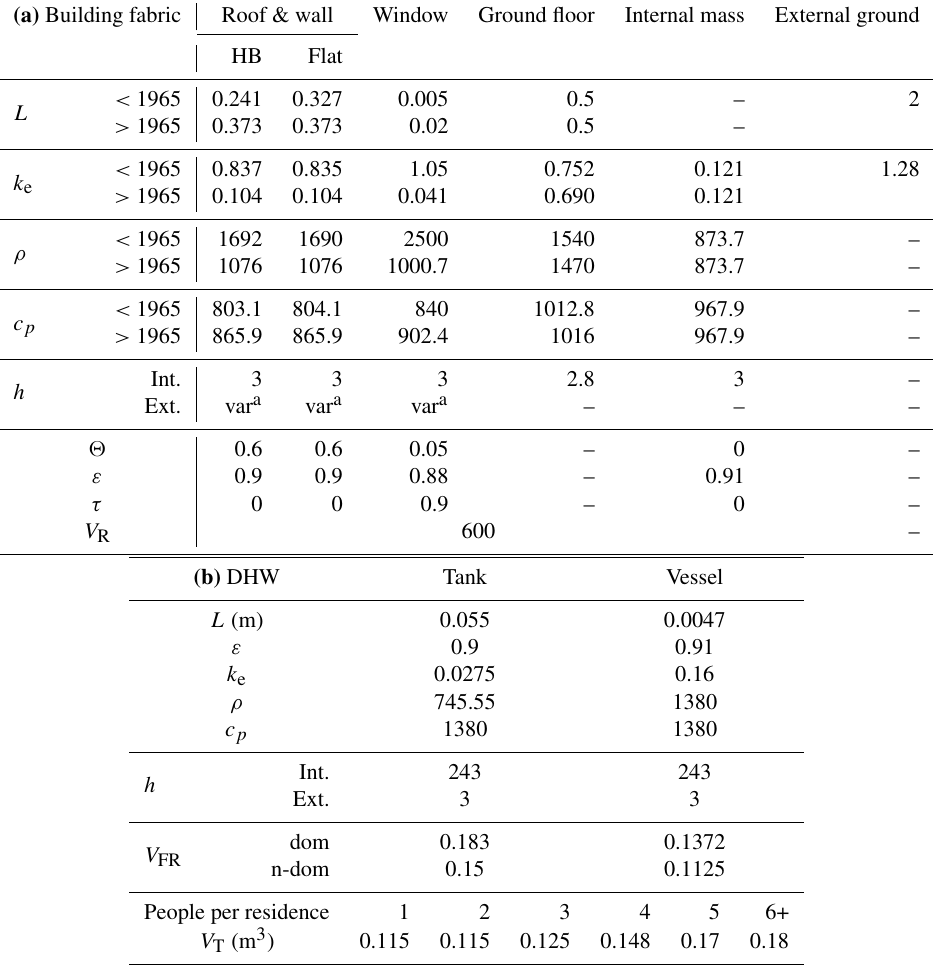
Table C2. Properties used in STEBBS vary by property age ( < 1965, > 1965), type (HB – house & bungalow; flat), component (roof etc.) for (a) building fabric and external ground, and (b) DHW. L : thickness (m); ε : emissivity; τ : effective transmissivity; (cid:50) : surface albedo; k e : effective thermal conductivity (Wm − 1 K − 1 ); ρ : density (kgm − 3 ); c p : specific heat of air at constant pressure (Jkg − 1 K − 1 ) (Internal Air 1005); h : convection coefficient (Int: internal, Ext: external) (Wm − 2 K − 1 ); V FR : volumetric flow rate of DHW per water user (dom: domestic, n-dom: non-domestic) (10 − 3 m 3 s − 1 ); V R : ventilation rate (10 − 3 m 3 s − 1 ); V T : DHW tank volume (m 3 ); WWR: window-to-wall ratio (0.4). Vessels: all other storage of DHW. For data sources refer to Table